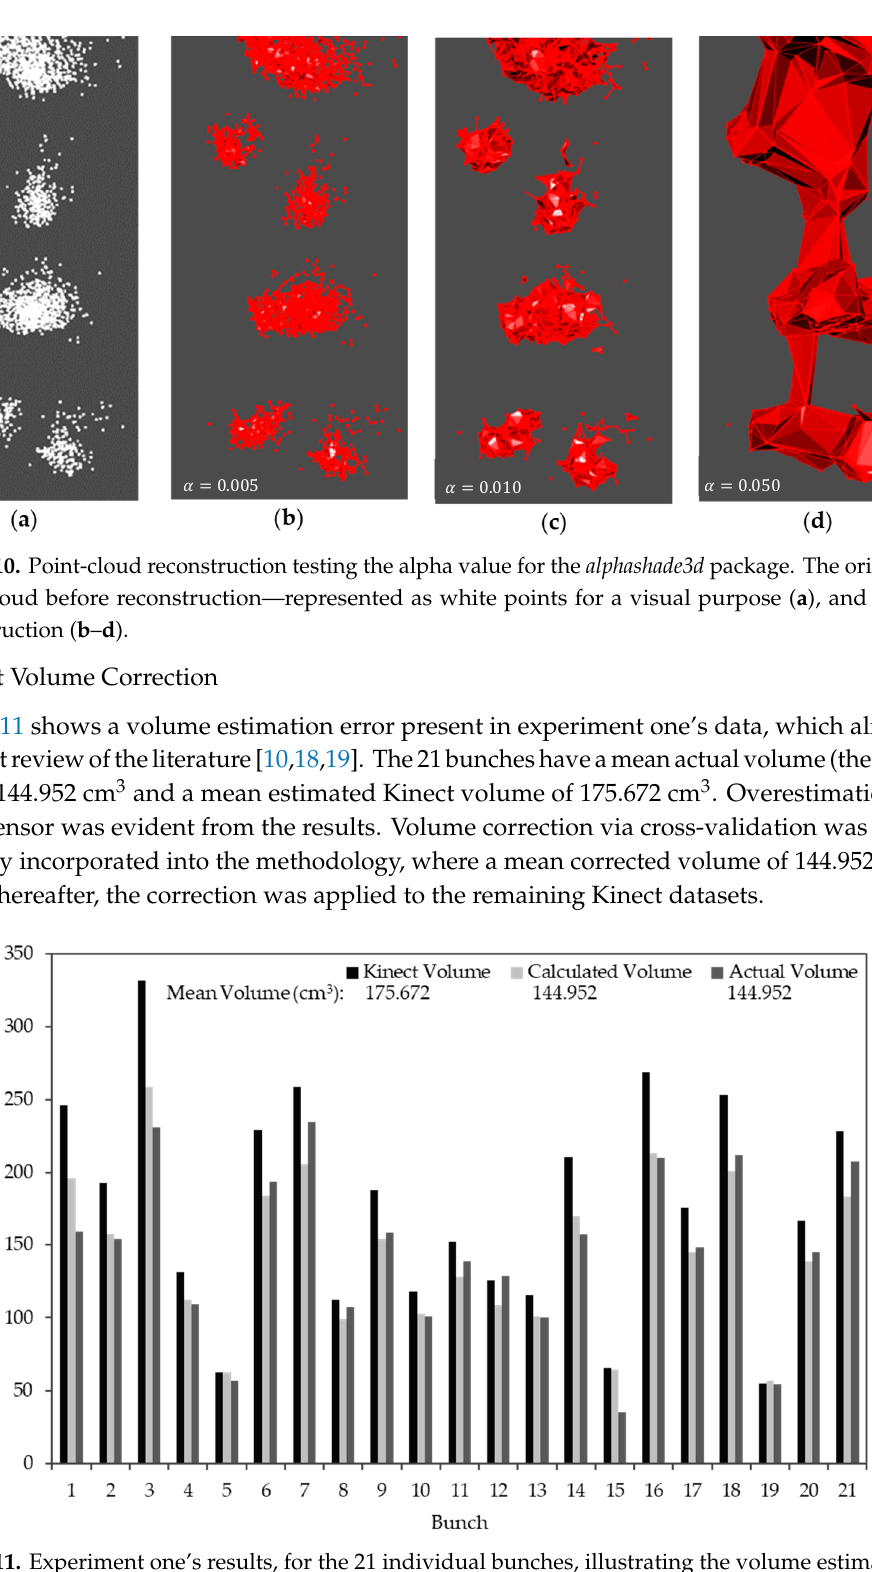
Figure 9. The relevant r 2 and RMSE values for each alpha value tested for the alphashape3d package in the custom R script. Alpha values incremented in 0.001, ranging from 0.001–0.050.